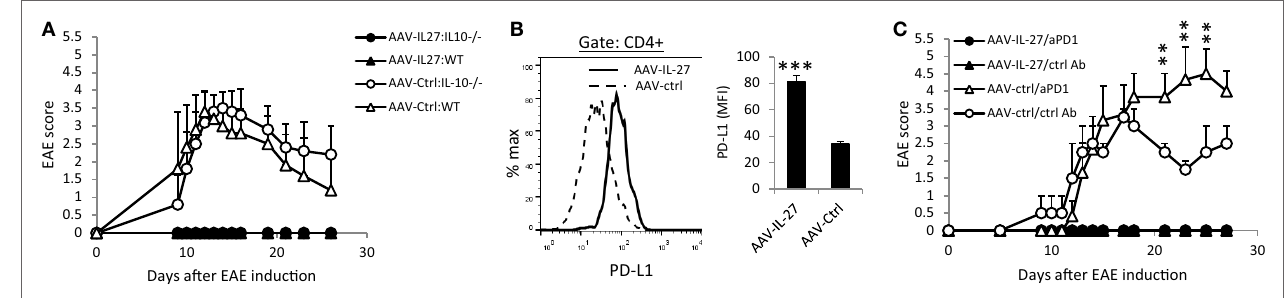
FigUre 4 | The role of IL-10 and PD-1 blockade in adeno-associated viral vector (AAV)-interleukin-27 (IL-27) mediated prevention of experimental autoimmune encephalomyelitis (EAE). (a) WT or IL-10 − / − mice were injected with AAV-IL-27 or AAV-ctrl virus i.m. at a dose of 2 × 10 11 DRP/mouse. One week later, EAE was induced in the AAV virus-treated mice. Five mice per group were used in this experiment, and data shown represent two experiments with similar results. EAE scores are expressed as means ± SD. (B) AAV-IL-27 treatment induced T cell expression of PD-L1. Representative FACS plot (left panel) and summary (right panel) of PD-L1 expression on spleen CD4 + T cells is shown. Three to four mice per group were included in this experiment, and data represent five experiments with similar results. Statistical analysis was performed using the unpaired Student’s t -test. **** P < 0.0001. (c) PD-1 blockade failed to break T cell tolerance in AAV-IL-27-treated mice. C57BL6 mice ( n = 4/group) were first treated with AAV-IL-27 or AAV-ctrl virus followed by EAE induction 1 week later. On days 5, 9, 13, and 17 after EAE induction, mice were also treated with 300 μ g/mouse of anti-PD-1 (RMP1-14) or an isotype-matched control antibody (2A3) i.p. EAE scores are expressed as means ± SD. Data shown represent three experiments with similar results. ** P < 0.01 by Student’s t